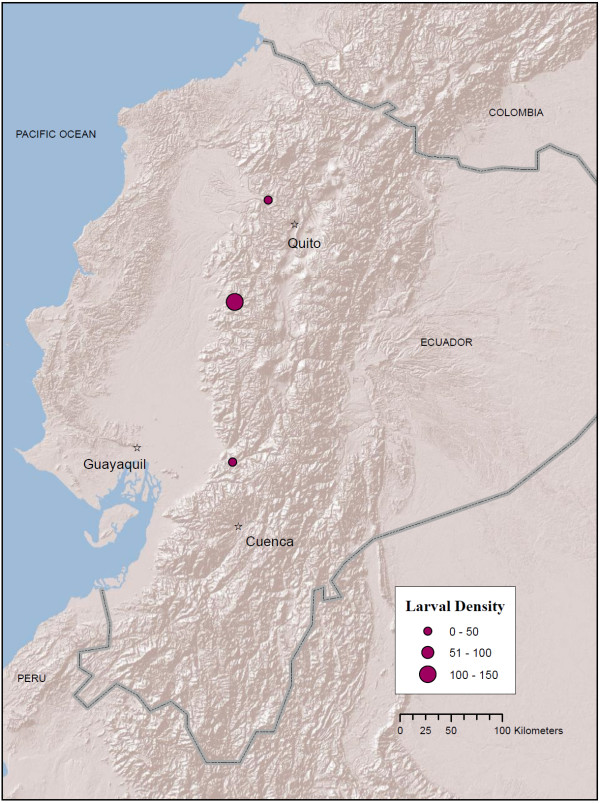
Map of An. eiseni localities in Ecuador (maroon circles) from larval collections conducted between 2008 - 2010. Circle size (legend) indicates mean number of larvae per dip in a 30-dip sample. Map prepared in ArcGIS v.9.3 with ESRI World Terrain base [59].